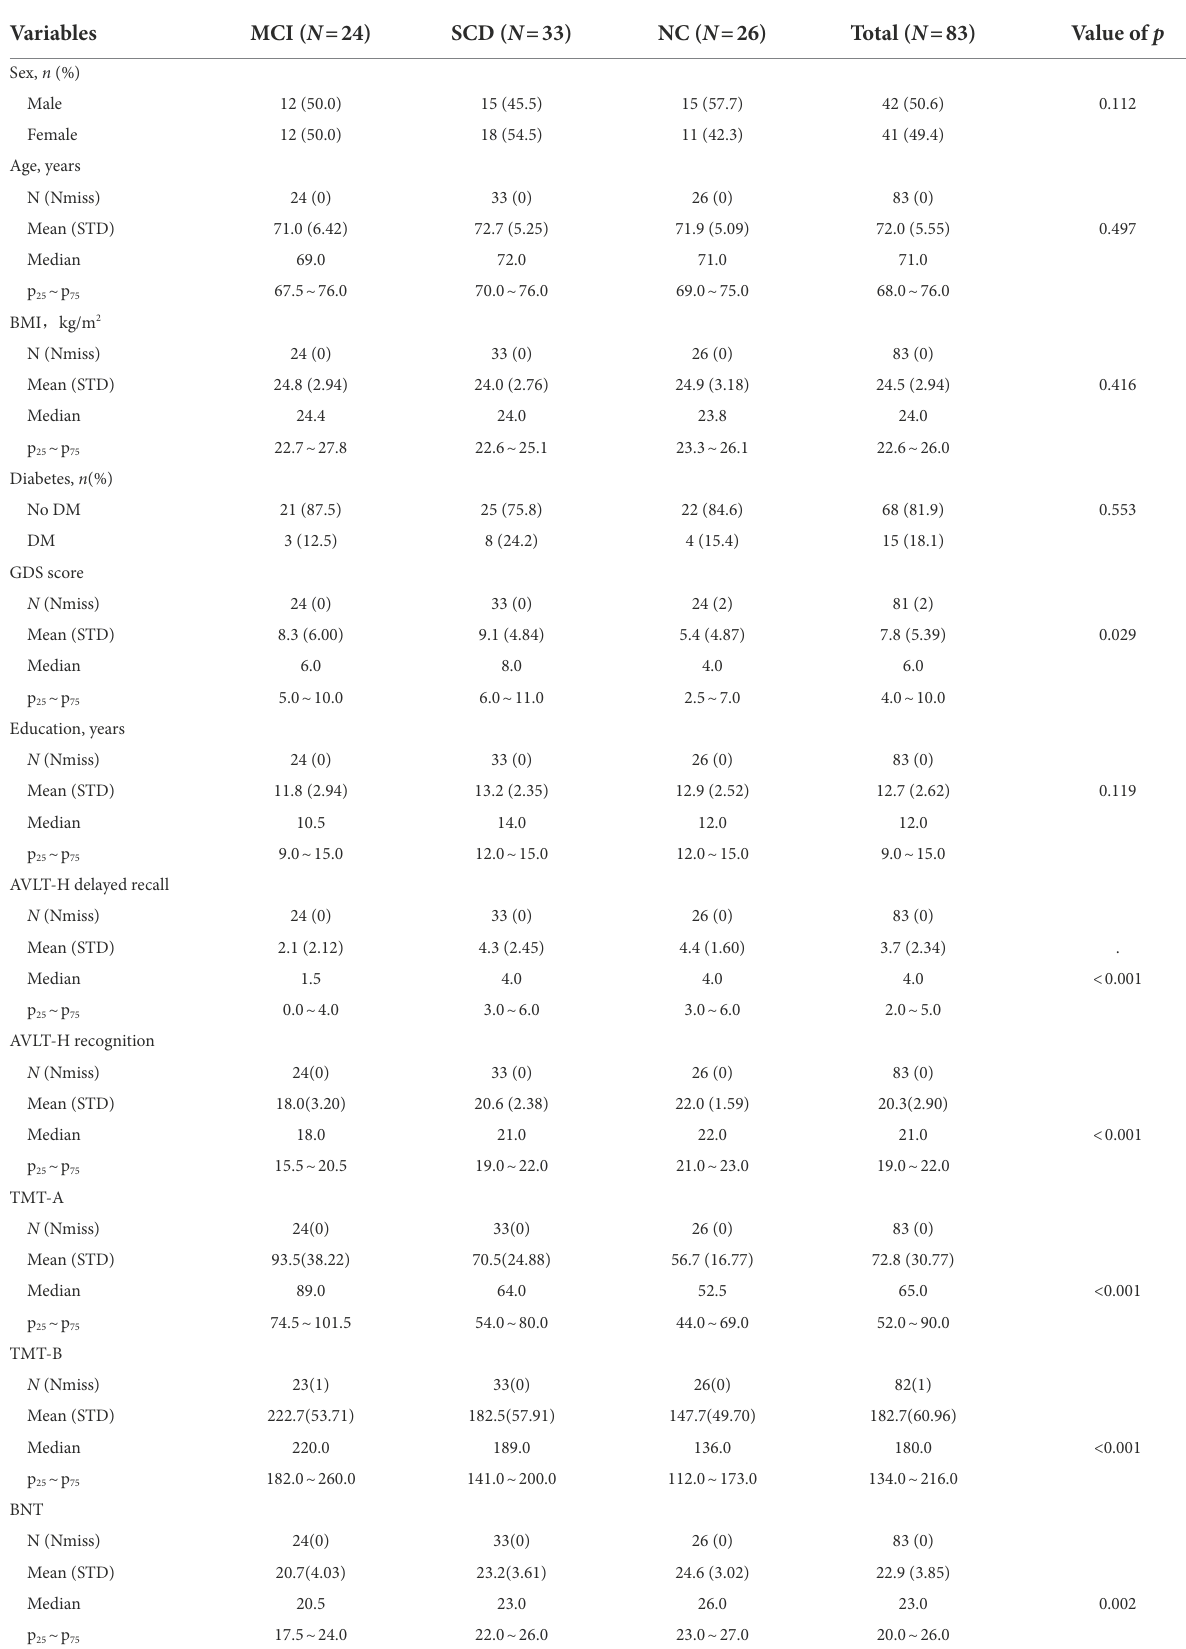
TABLE 1 Baseline characteristics of the